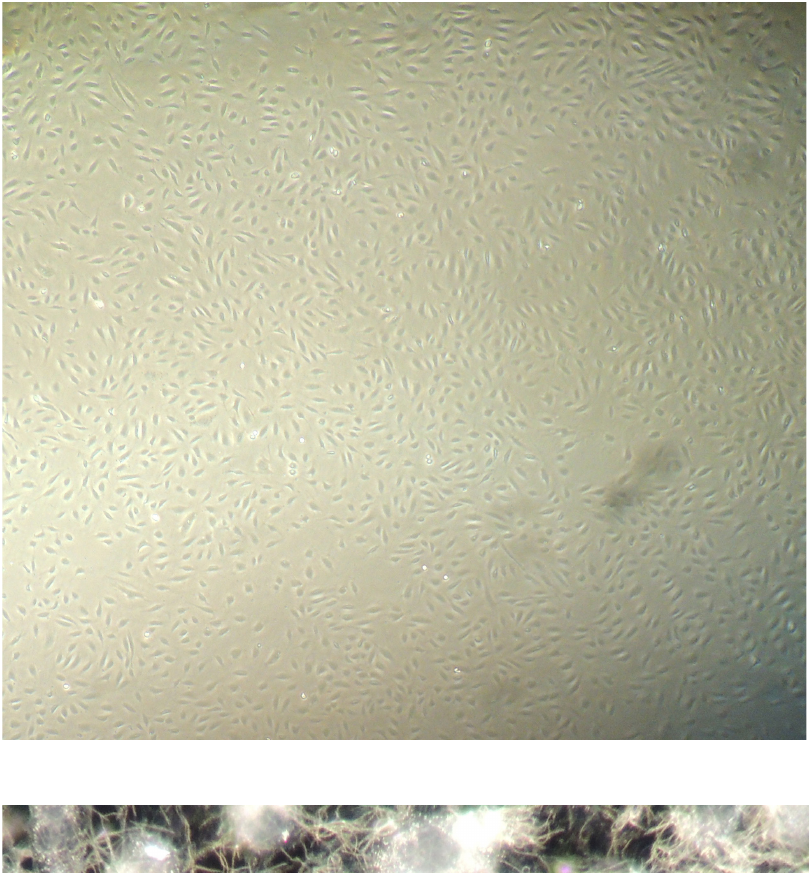
Figure 2. The graph of HBMECs co-incubated with T. pallidum with a dark-field microscopy (1000x). We could see T. pallidum attached on the